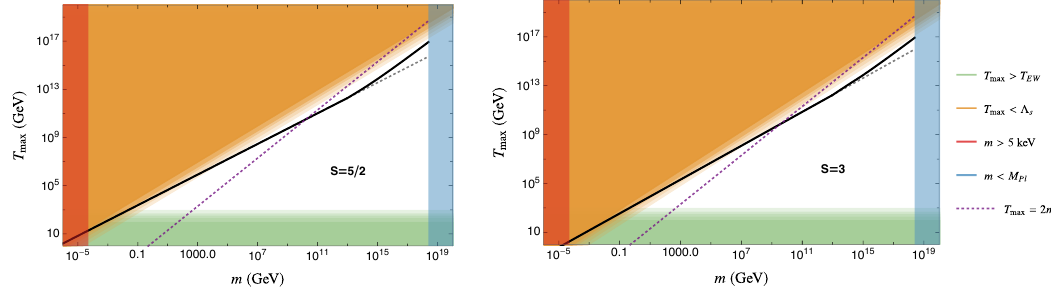
Figure 3: Spin-5 / 2 (left) and spin-3 (right) DM gravity-mediated scenario without contact terms. See the caption of Fig. 2 for